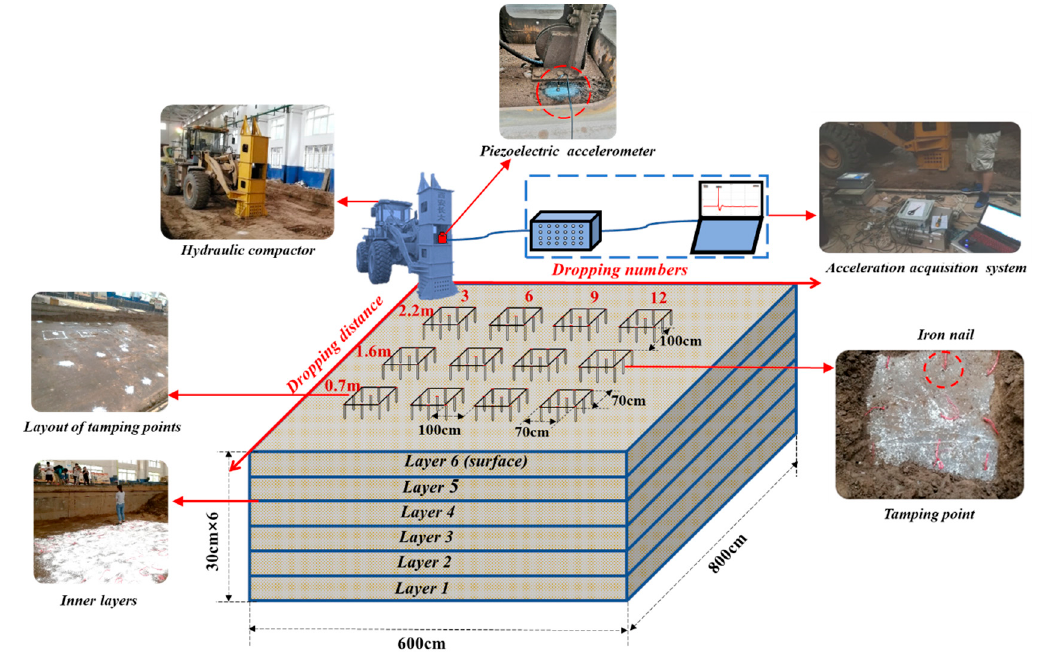
Figure 5. Test model and scheme design of hydraulic compactor for reinforcing loess subgrade.